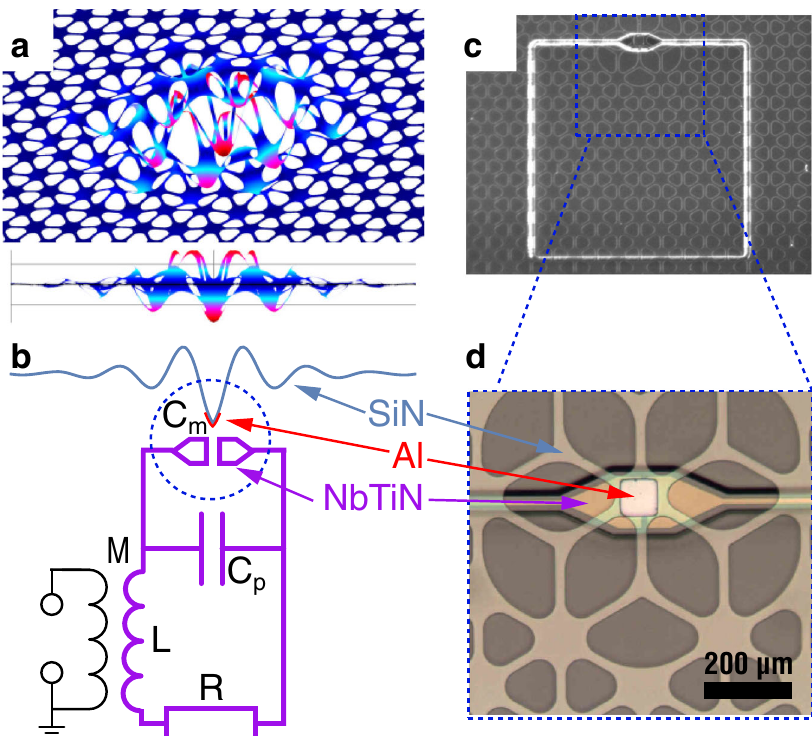
Fig. 1 Electromechanical system. a Bird ’ s (top) and side (bottom) view of the simulated displacement of the mechanical mode localized at the defect in the phononic crystal patterned into a silicon nitride (SiN) membrane. False-color indicates displacement amplitude from small (blue) to large (red). b The membrane defect is metallized with a pad of aluminum (Al) and brought into proximity of two electrode pads on a different chip, thereby forming a mechanically compliant capacitance C m . This capacitor is part of a microwave `loop-gap' resonator made from the superconductor NbTiN, together with a parallel parasitic capacitance C p , inductivity L and resistance R . Microwave power is coupled into this circuit through the mutual inductance M . c Gray-scale optical micrograph (top view) of the fl ip-chip, in which the microwave loop-gap resonator (bright square) shines through the largely transparent patterned membrane. d Color zoom onto the mechanically compliant capacitor, showing the square Al metallization on the patterned membrane above the NbTiN capacitor pads.